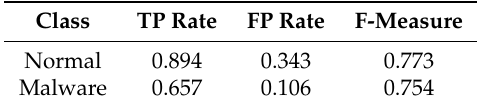
Table 13. Performance of the One-class SVM on the ADFA dataset.